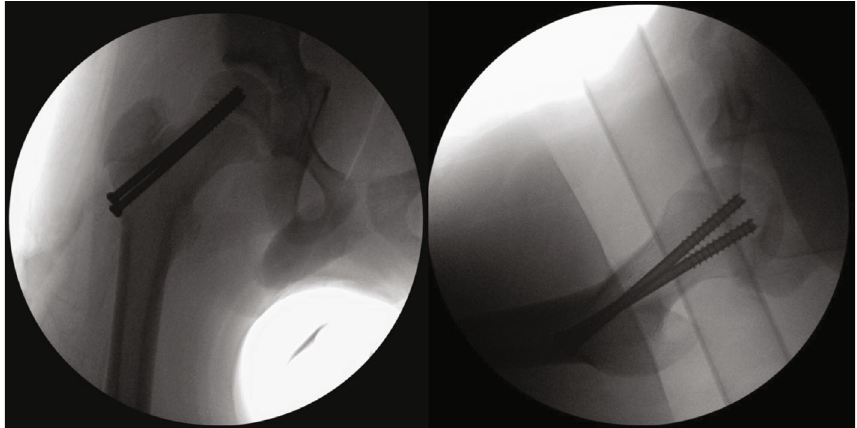
Figure 3: Intraoperative AP and lateral fl uoroscopy views demonstrating the reduced right hip joint and fi xation of right capital femoral epiphysis.